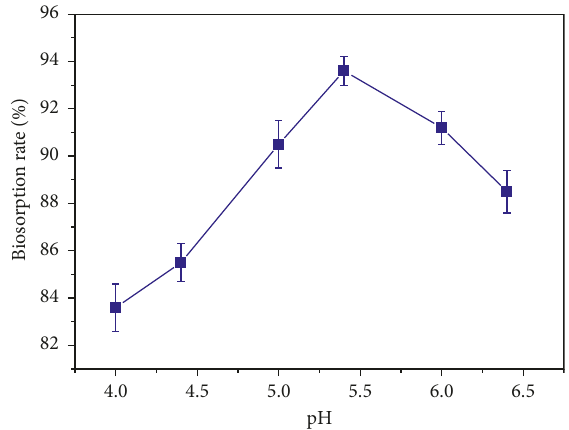
Figure 2: Effect of pH values on biological modification.